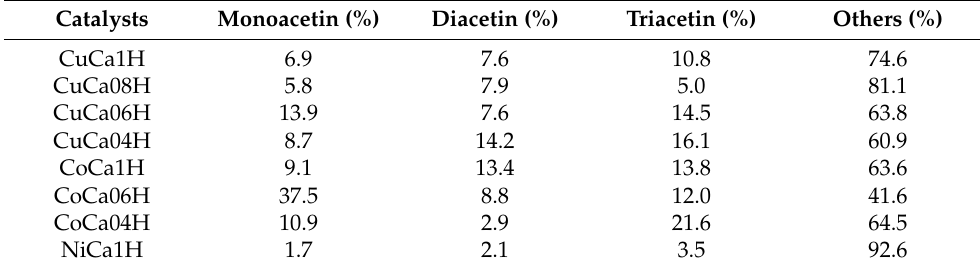
Table 1. The product selectivities for the catalysts tested in 6h of EG reaction. Reaction conditions: 75 mg of catalyst, glycerol to acetic acid molar ratio of 0.25, and reaction temperature = 80 ◦ C. Catalysts Monoacetin (%) Diacetin (%) Triacetin (%) Others (%)